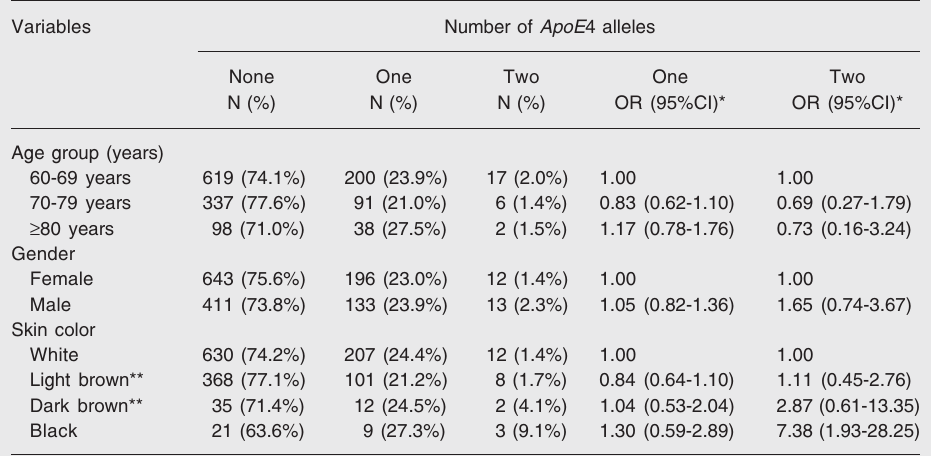
Table 2. Association of the number of ApoE 4 alleles among 1408 elderly participants at baseline of the Bambuí Health and Aging Study with selected demographic characteristics (Brazil). Variables Number of ApoE 4